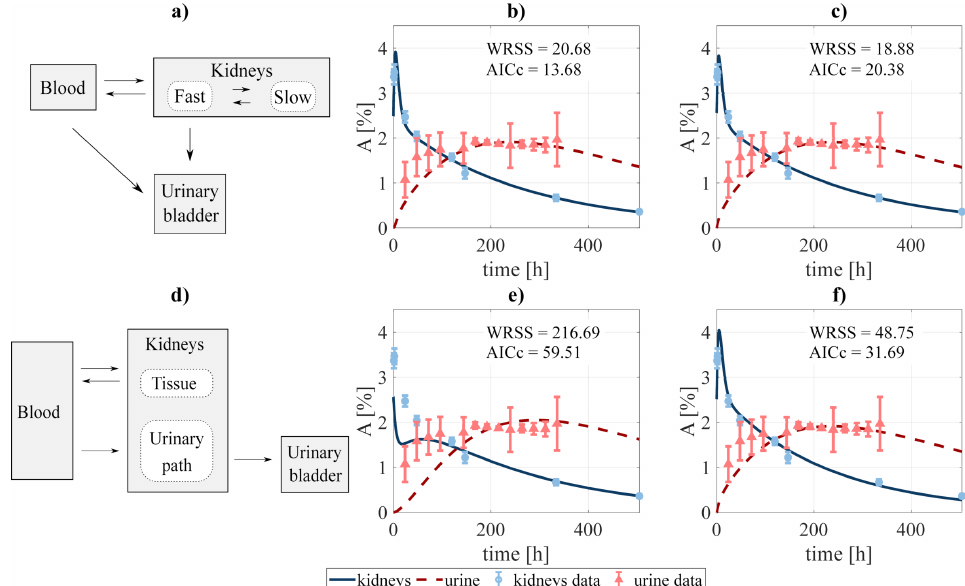
Figure 2. Compartmental design to perform the system decoupling for the excreted activity data: ( a ) the activity to be excreted can come from the fast component of the kidneys and directly from the blood. The data was fit to several combinations of the system, defined by removing none or some rate constants, among them: ( b ) blood-bladder and slow-to-fast components removed, and ( c ) none were removed. A second scheme ( d ) was tested, where the excreted activity travels from the blood to the urinary bladder passing through the urinary path (structure analog to that used by [40] for FCH). The fitting was carried out for the cases where ( e ) tissue-blood component, and ( f ) no components were removed. WRSS and AIC c refer to the weighted residual sum of squares and Akaike Information Criterion with sample size correction of the